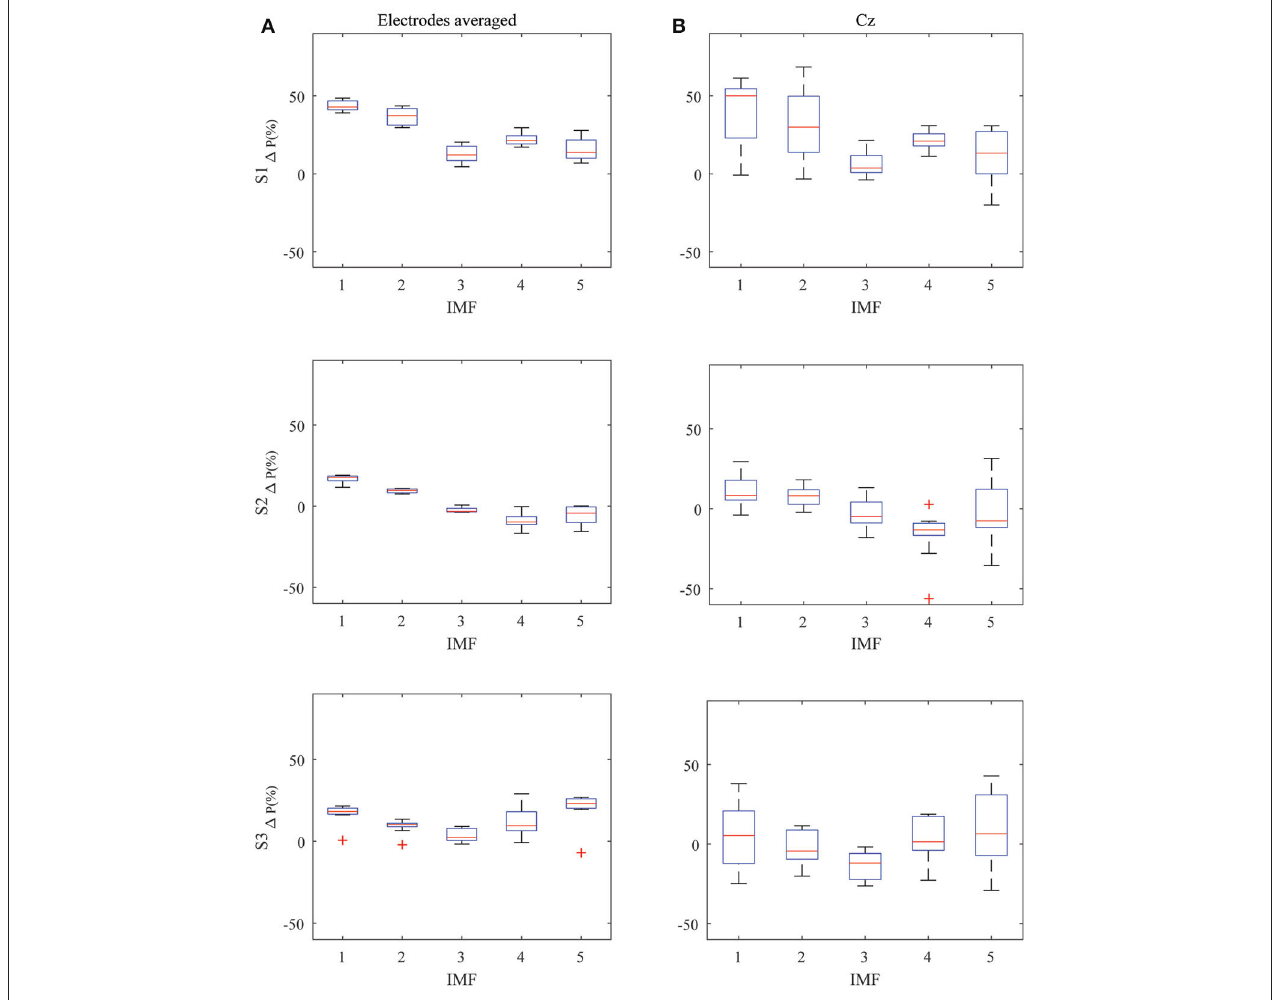
FIGURE 5 | Boxplot of the variation of power of the MI tasks related to the relaxed state: (A) Left image shows the variation of power for the nine electrodes averaged through the 10 trials placed in the motor cortex zone. (B) Left one shows it for the electrode Cz for the individual 10 single trials.